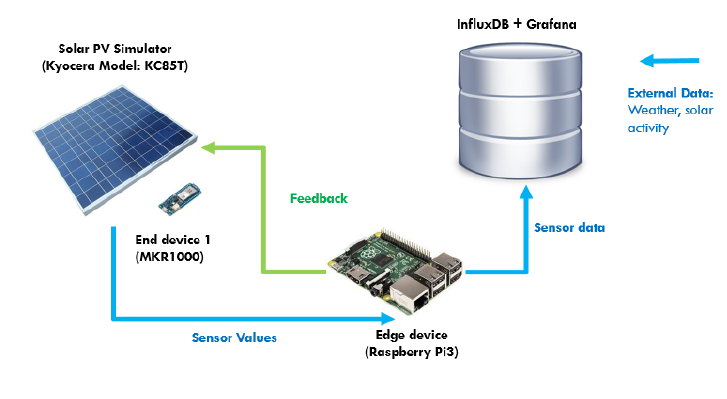
Figure 2. Hardware illustration of Edge IoT system (MPPT use